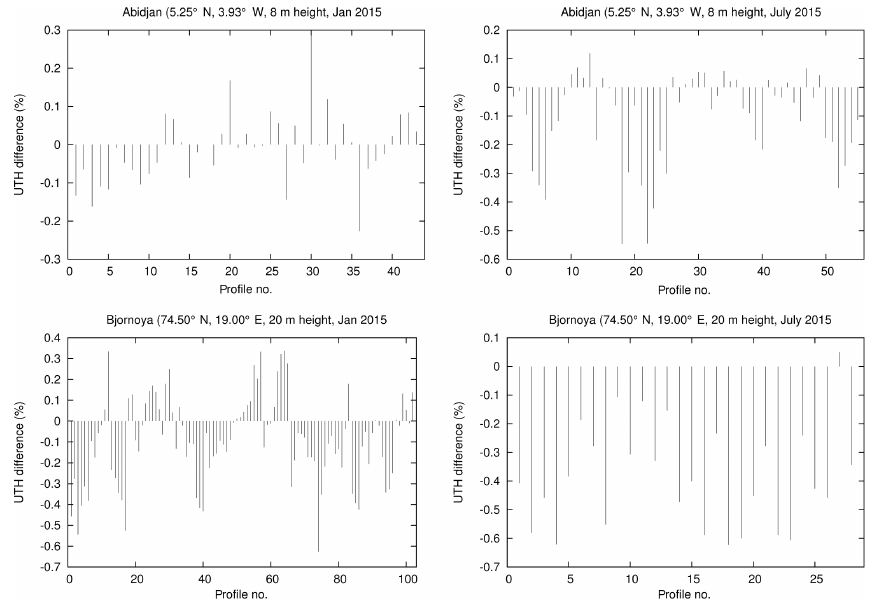
Figure 5. UTH differences for changes in the peak emission altitude and water vapour scale height for tropical station Abidjan and polar station Bjørnøya (Bear Island). Peak emission altitude is assumed to rise by 50m, scale height by